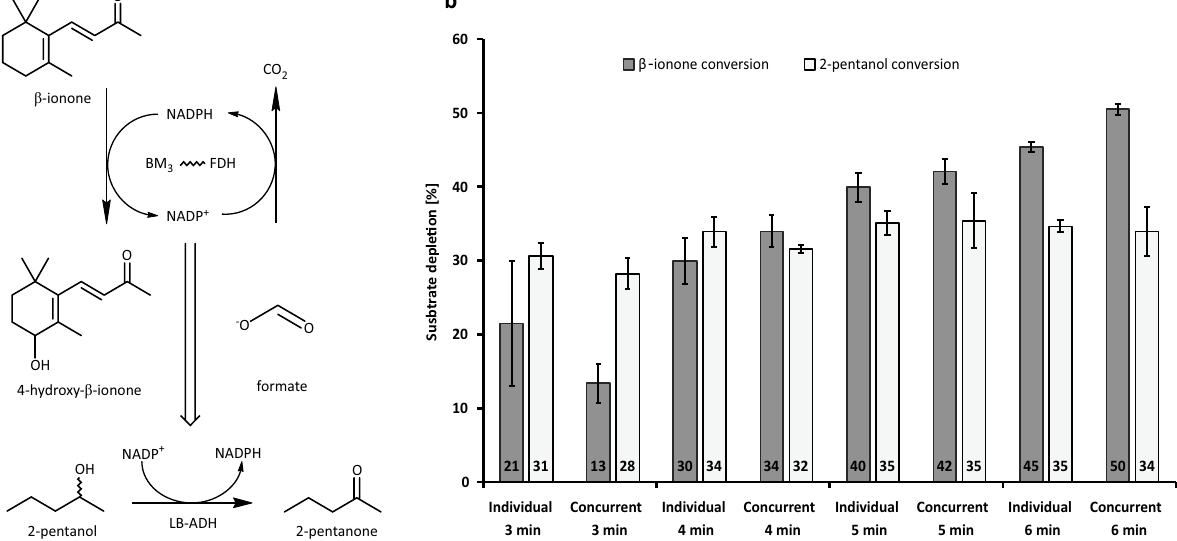
Figure 4. Determination of NADP + channeling within the fusion construct F2B in the presence of LB-ADH as a competitive enzyme. ( a ) Reaction scheme for conversion of β-ionone to 4-hydroxy-β-ionone by a BM3-FDH fusion and the introduction of LB-ADH that competes with the FDH for NADP + . ( b ) Conversion of 2-pentanol to 2-pentanone by LB-ADH (ADH) and the conversion of β-ionone to 4-hydroxy-β-ionone by F2B was conducted either separately (marked as “Individual”) or in one pot (marked as “Concurrent”). Concentrations of the products were measured after the depicted time